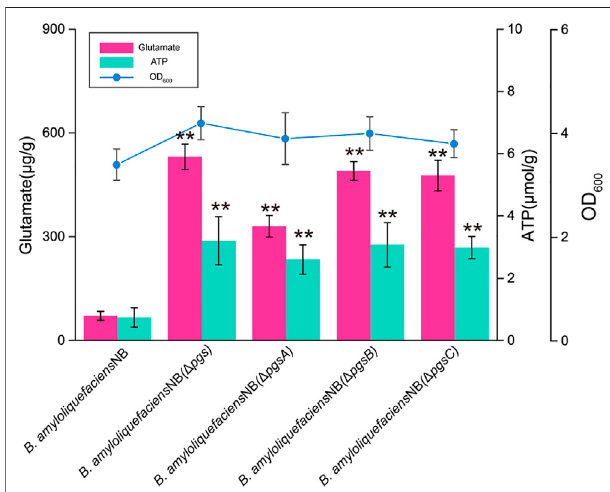
FIGURE 1 | The lack of polyglutamate synthase ( pgsBCA ) improves glutamate and ATP concentrations and growth. Biomass and glutamate and ATP concentrations for B. amyloliquefaciens NB, B. amyloliquefaciens ( Δ pgsBCA ), B.amyloliquefaciens ( Δ pgsA ), B.amyloliquefaciens ( Δ pgsB ), and B. amyloliquefaciens ( Δ pgsC ) in shake fl asks at 24 h . All data were the average of three independent studies with standard deviations. The ** and * indicate p < 0.01 and 0.05 relative to the control strain B. amyloliquefaciens NB,